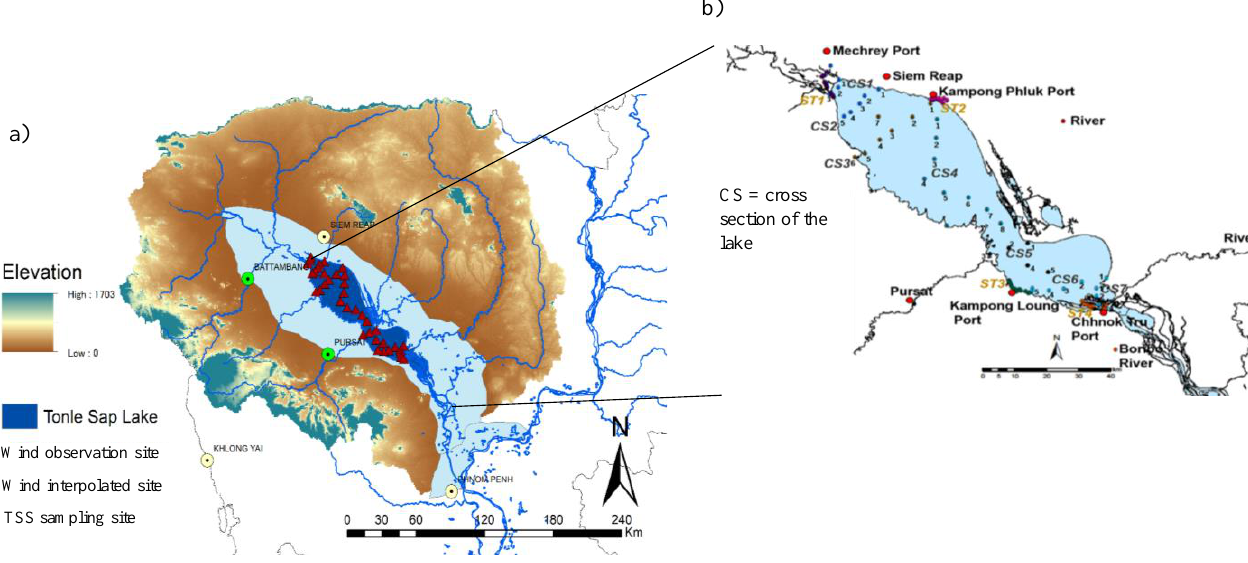
Figure 1. ( a ) Study area and ( b ) cross sections (CS) of Tonle Sap Lake, Cambodia, for the sampling of total suspended solids.